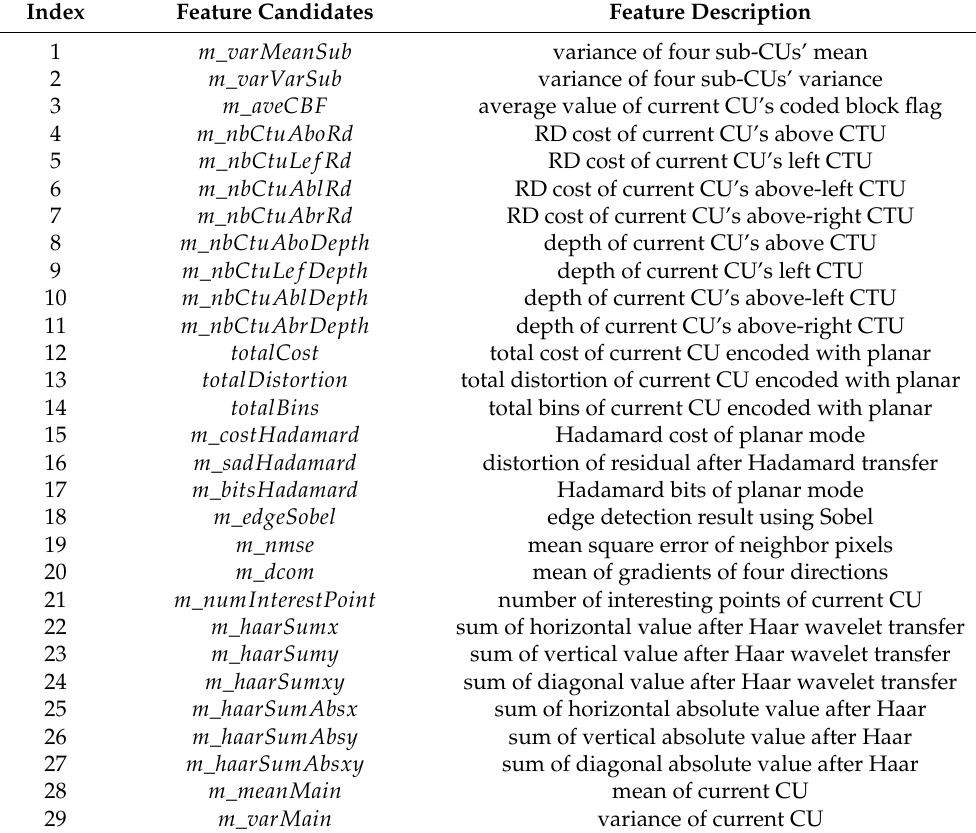
Table 1. Feature candidates and corresponding